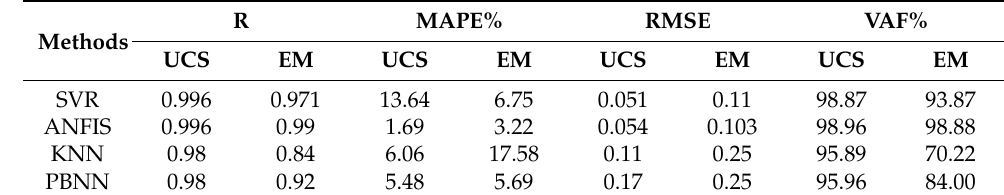
Table 10. The precision of the intelligent methods used for all data.